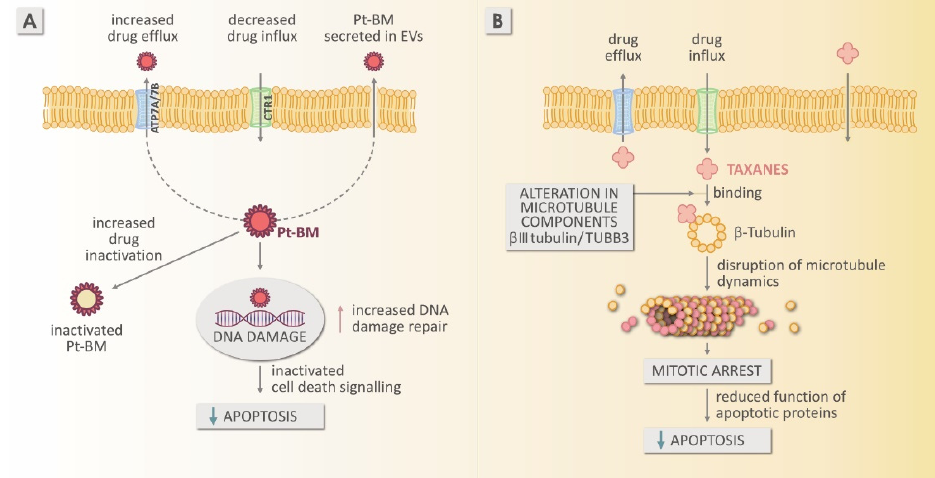
Figure 2. Major mechanism of resistance to Pt-BMs is shown on Section A and to taxanes on Section B . Pt-BM = platinum-based medicine; EVs = extracellular vesicles.